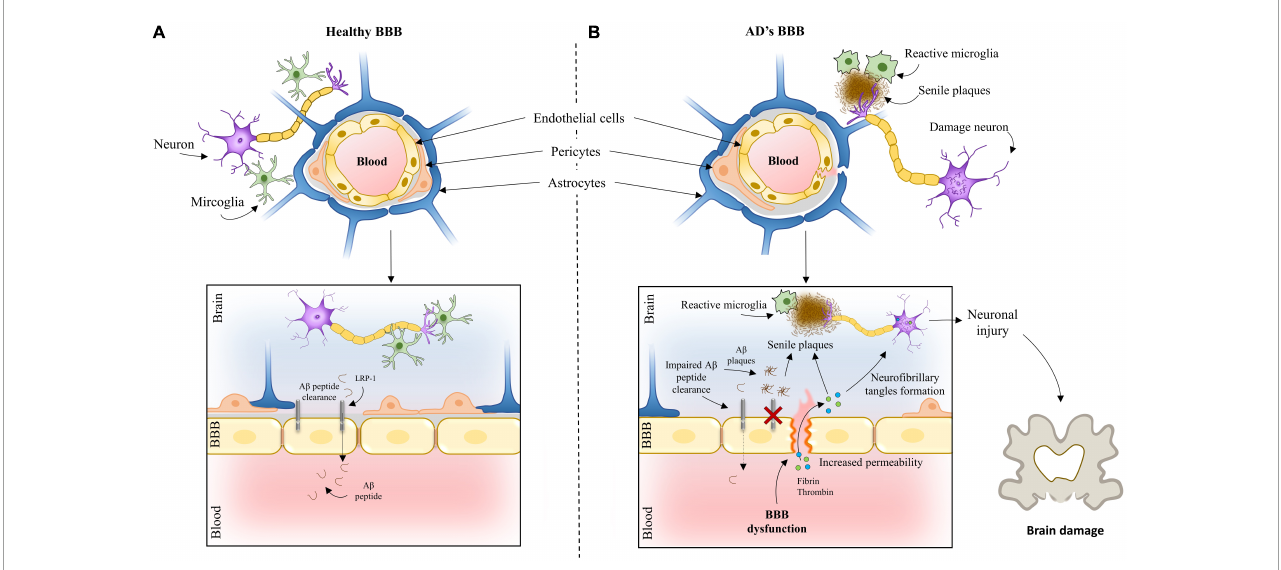
FIGURE1 The blood-brain barrier in an (A) healthy brain and (B) Alzheimer’s